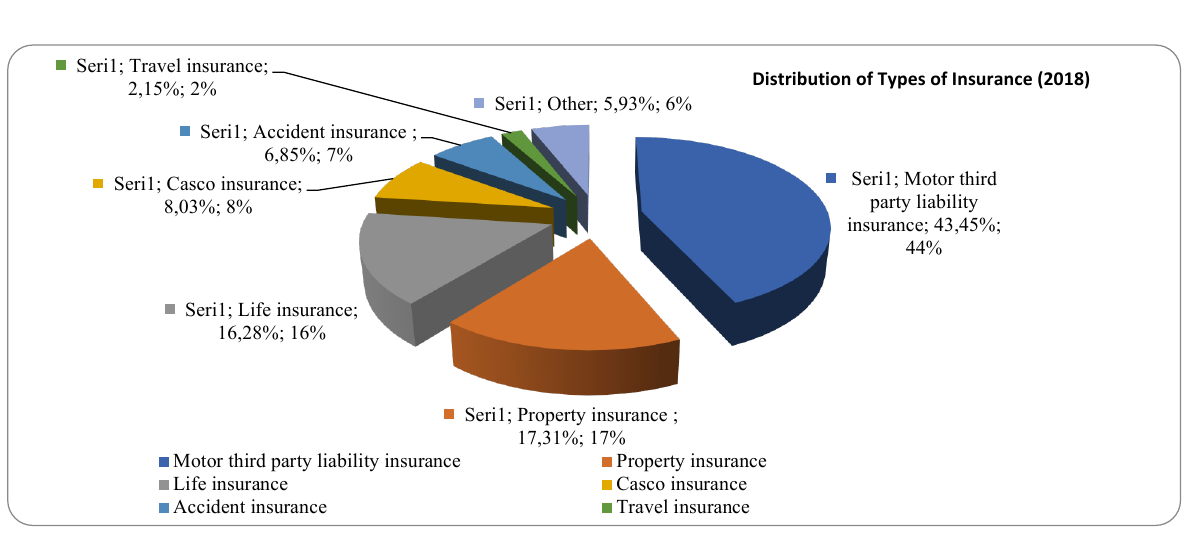
Figure 2: Distribution of total premium generation by types of insurance; Source: ASO